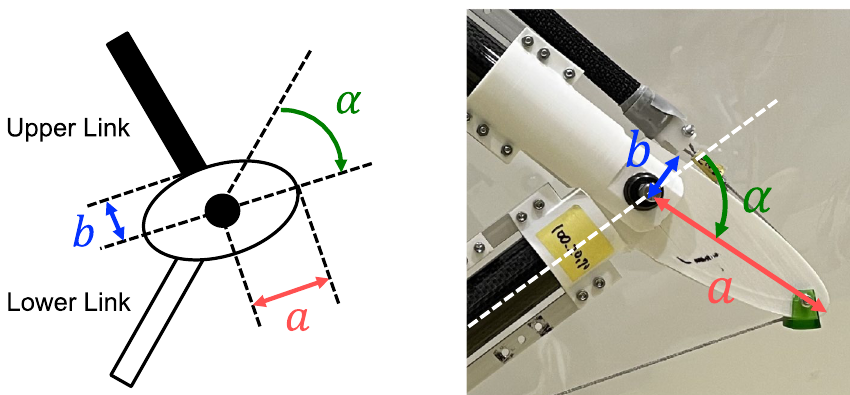
Fig. 4 Definition and schematic of shape parameters a , b , α for elliptical patella (left) and actual robot patella used in the experiment (right)